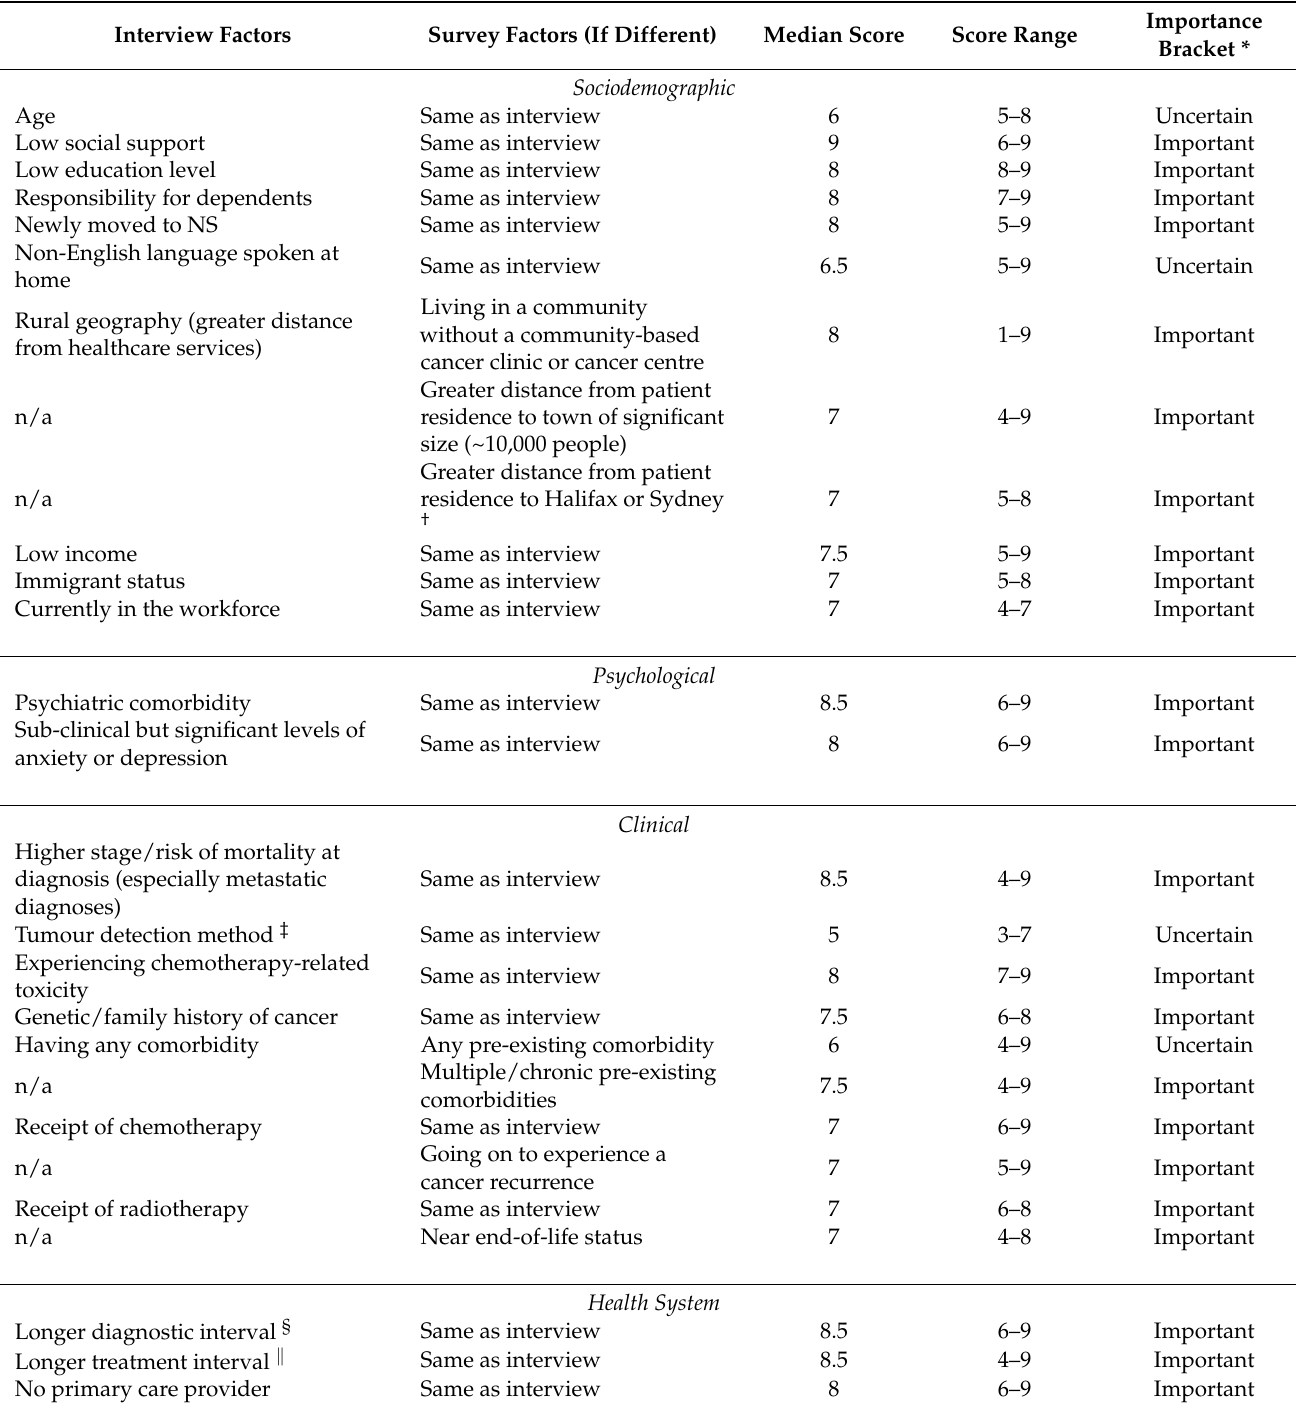
Table 2. Factors investigated for association with a greater need for navigation and their agreed importance, according to interviews and Delphi survey of